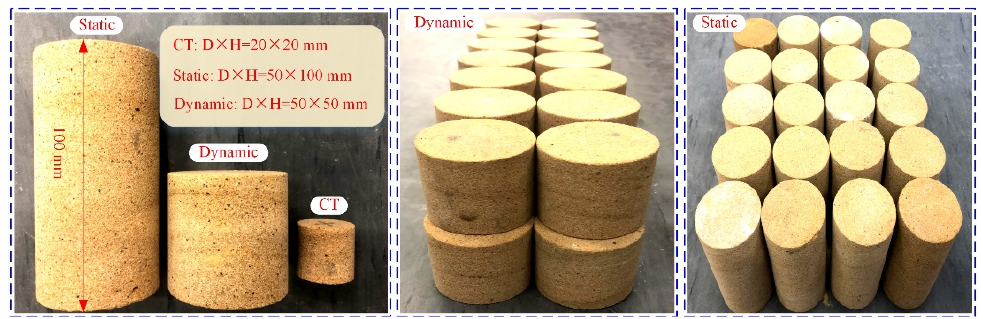
Figure 1. Diagram of static and dynamic samples. Table 1. Mean values of physico-mechanical parameters of yellow